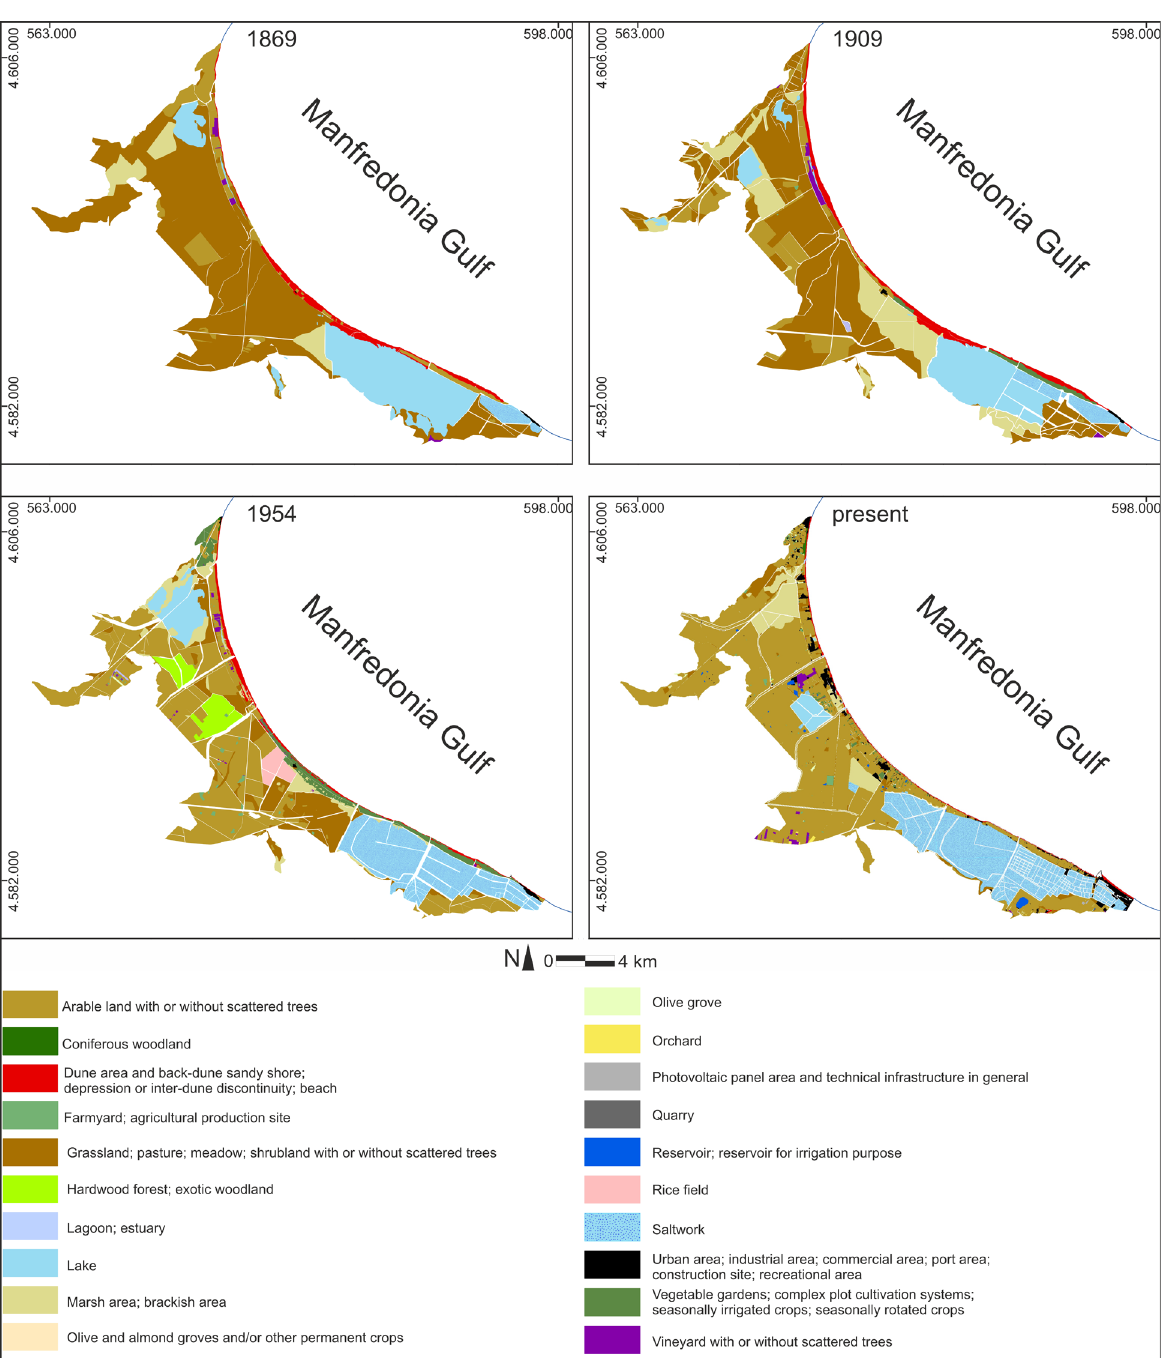
Figure 4. Spatial classification of the land use categories identified in the study area in 1869, 1909, 1954, and the present day.